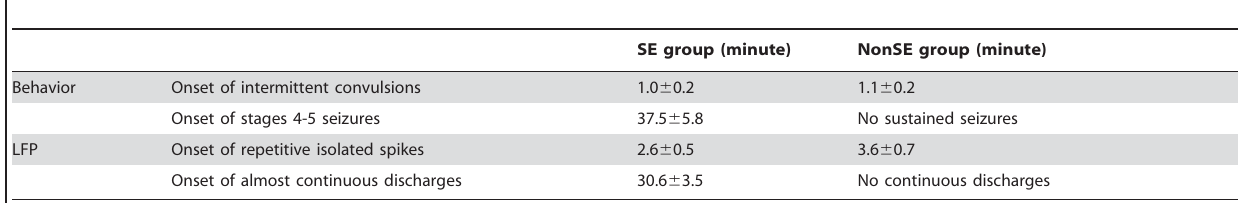
Figure 3. Local field potentials in 10-sec time windows of representative SE and nonSE rats at baseline period (upper panel) and at 5 min (middle panel) and 85 min (lower panel) after pilocarpine treatment. doi:10.1371/journal.pone.0039763.g003 Table 1. Mean onset time ( 6 SEM) of status epilepticus (SE) relative to behavioral and local field potential (LFP) patterns after i.p. pilocarpine injection in nonSE and SE